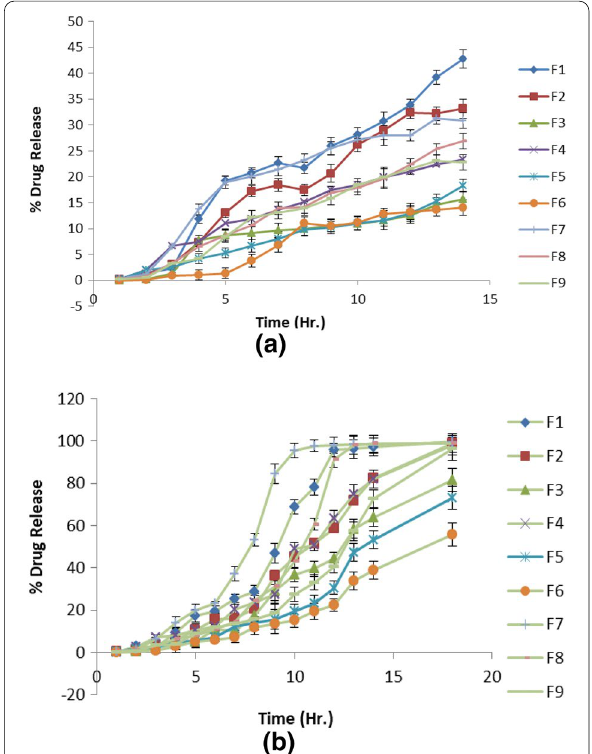
Fig. 1 Dissolution profiles of satranidazole pellets (Batch F1–F9) (Table 2) at a simulated gastrointestinal fluid (pH 1.2, pH 4.5 & pH 7.4) and b simulated colonic fluid (pH 7)